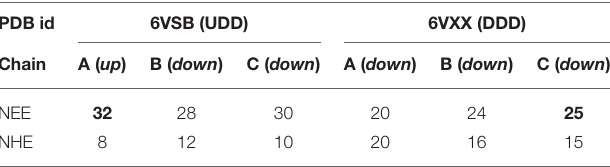
TABLE 2 | Location of the epitopes at different interfaces for SARS-CoV-2 wt S homotrimer.